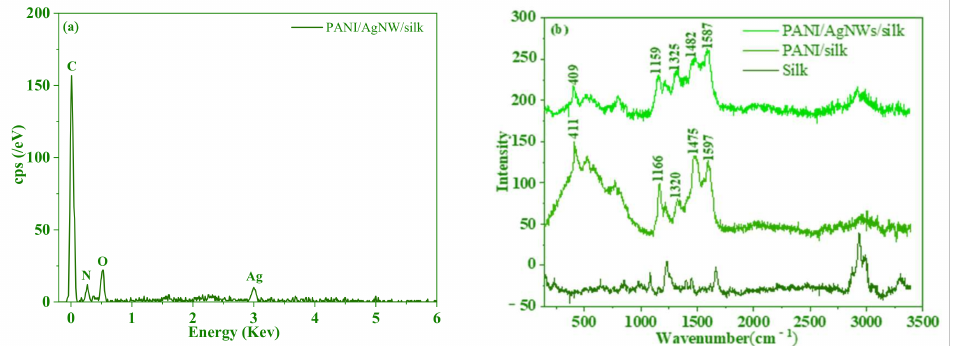
Figure 4. EDS spectrum of PANI/AgNWs/silk ( a ) and Raman spectra of the silk, PANI/silk and PANI/AgNWs/silk composites ( b ).